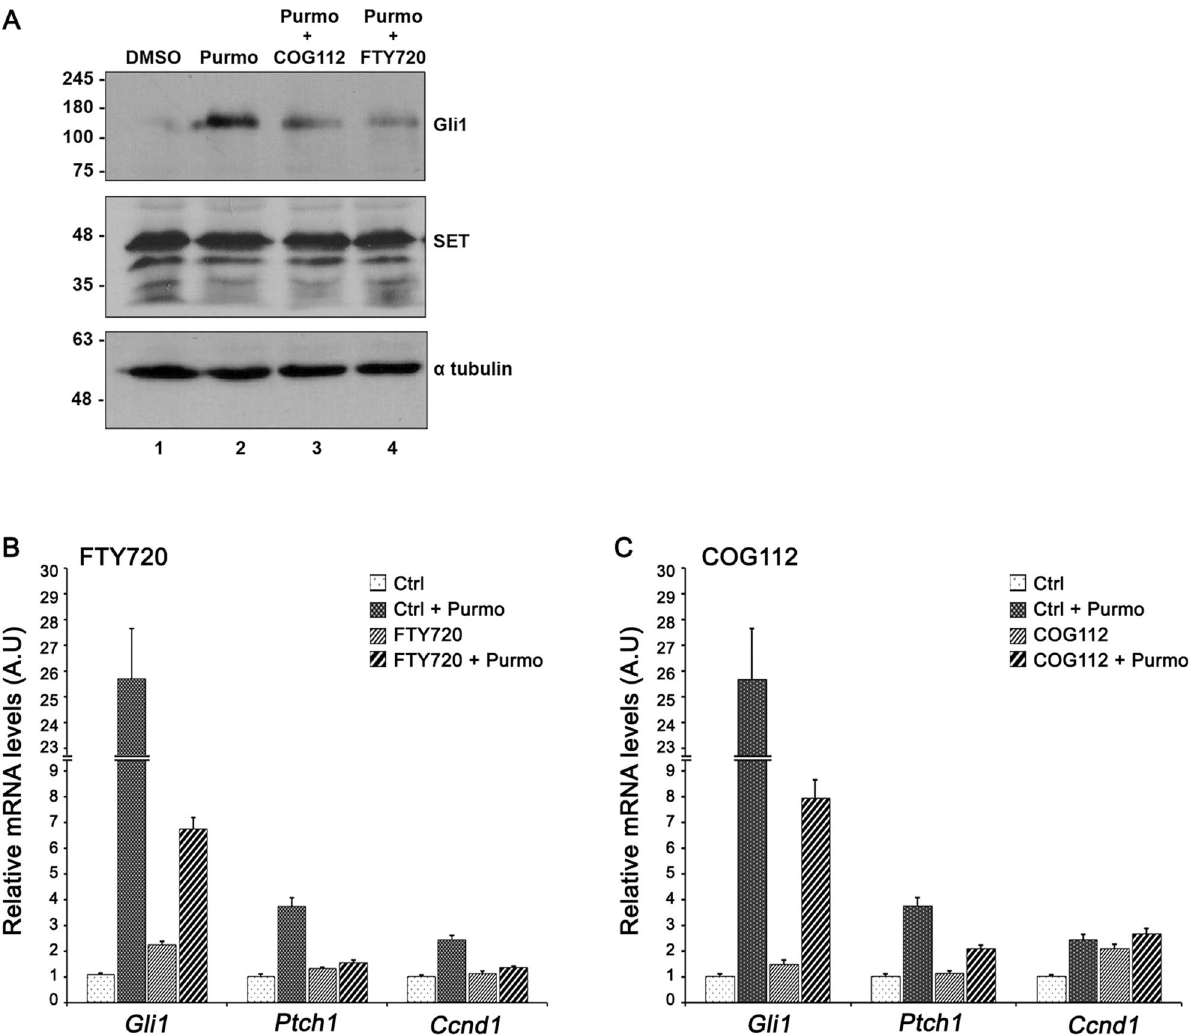
Figure 4. SET inhibitors decrease Gli1 expression. ( A ) The effect of FTY720 and COG112 on Gli1 protein expression. Western blot analysis of extracts obtained from NIH 3T3 cells after incubation at 0.5% serum with DMSO (lane 1) or 2 μM purmorphamine (lane 2) in the presence of 3 μM COG112 (lane 3) or 5 μM FTY720 (lane 4). Proteins were resolved in 10% SDS-PAGE and the blots were probed with the anti-Gli1, anti-SET and anti-α-tubulin antibodies (loading control). Original uncropped Western Blot images of panel A are shown in Supplementary Fig. 2S. ( B , C ). The effect of FTY720 and COG112 on the mRNA levels of selected genes related to Hedgehog signaling. Comparison of relative expression differences for Gli1 , Ptch1 , and Ccnd1 in NIH 3T3 cells cultured at 0.5% serum after incubation with 2 µM purmorphamine in the presence of 5 μΜ FTY720 or 3 μΜ COG112, as determined by qPCR analysis. The mRNA levels of the genes were normalized to Gapdh . The experiments were repeated three times. Data are expressed as mean ± SEM *** p <